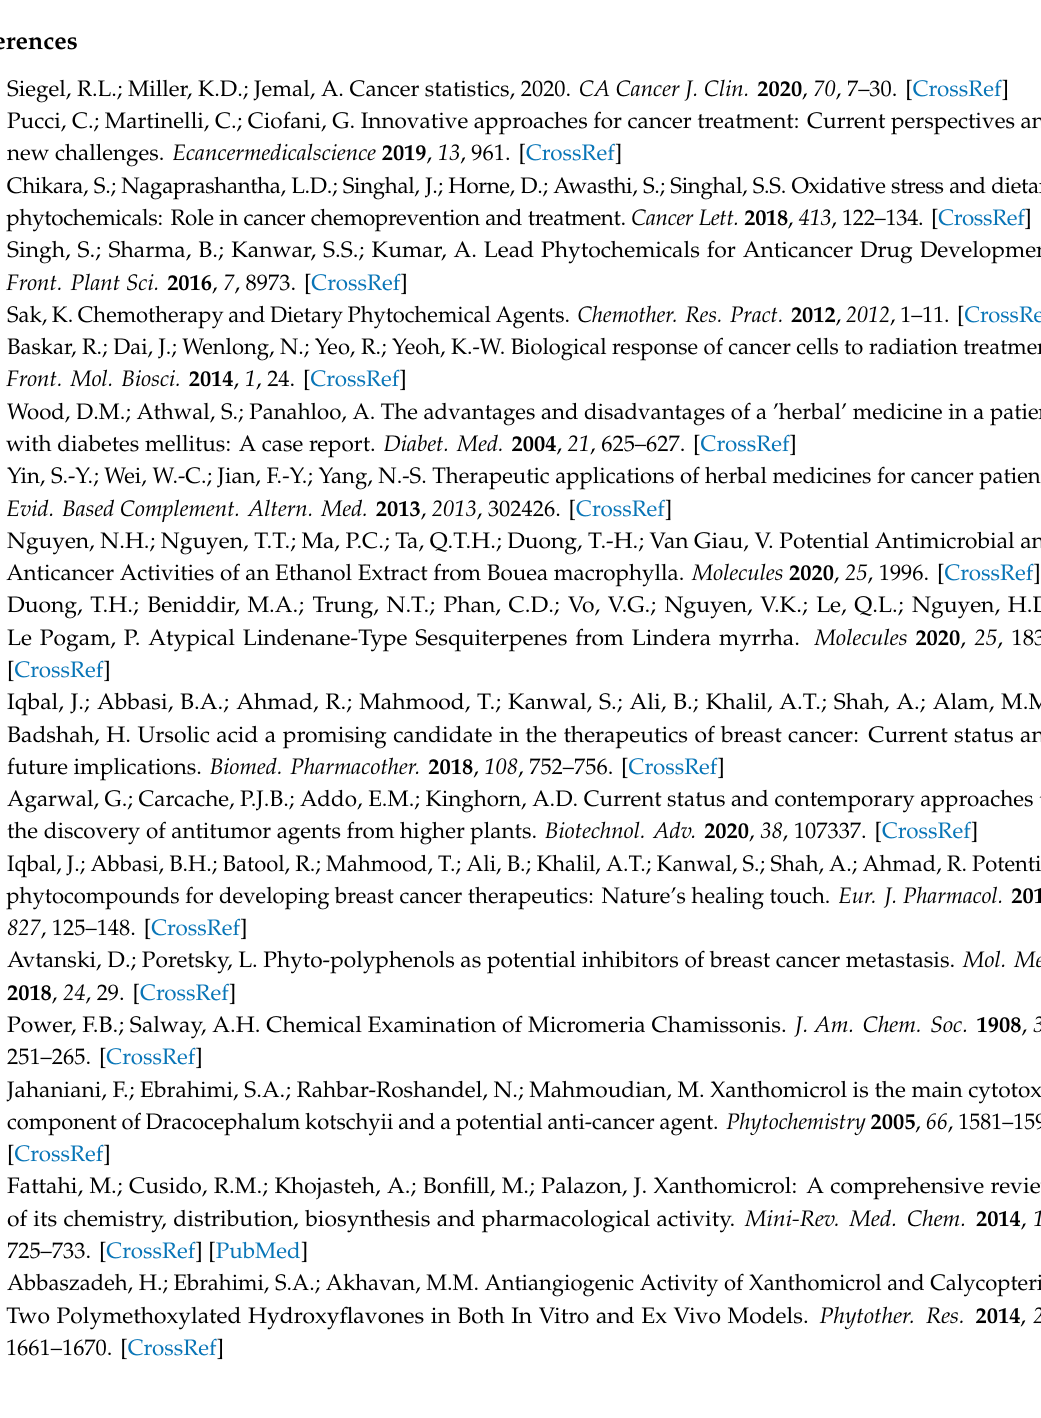
in acetone- d 6 . Figure S8: The 13 C NMR spectrum of AB2 in acetone- d 6 . Figure S9: HSQC spectrum of AB2 in acetone- d 6 . Figure S10: HMBC spectrum of AB2 in Acetone- d 6 . Figure S11: The 1 H NMR spectrum of AB3 in DMSO- d 6 . Figure S12: The 13 C NMR spectrum of AB3 in DMSO- d 6 . Table S1: NMR spectral data of AB1 and AB2 compounds. Table S2: Compare AB3 compound spectral data and